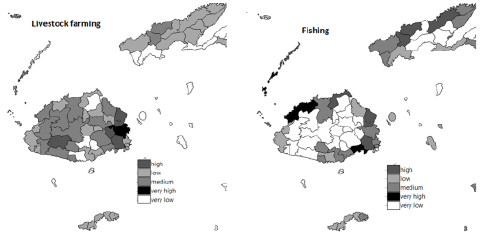
Figures 4a. Fiji islands map showing degrees of livestock farming per tikina . Range: 0 to 63 workers. All of Fiji‘s livestock production is used locally, even though the government invested heavily, little changed from 1989 to 2004 (Walsh and Crosbie 2006). Figure 4b. The country‘s map showing degrees of fishing activity per tikina. Range: 0 to 247 workers. Fishing at $85million was Fiji‘s third largest export after garments and sugar.